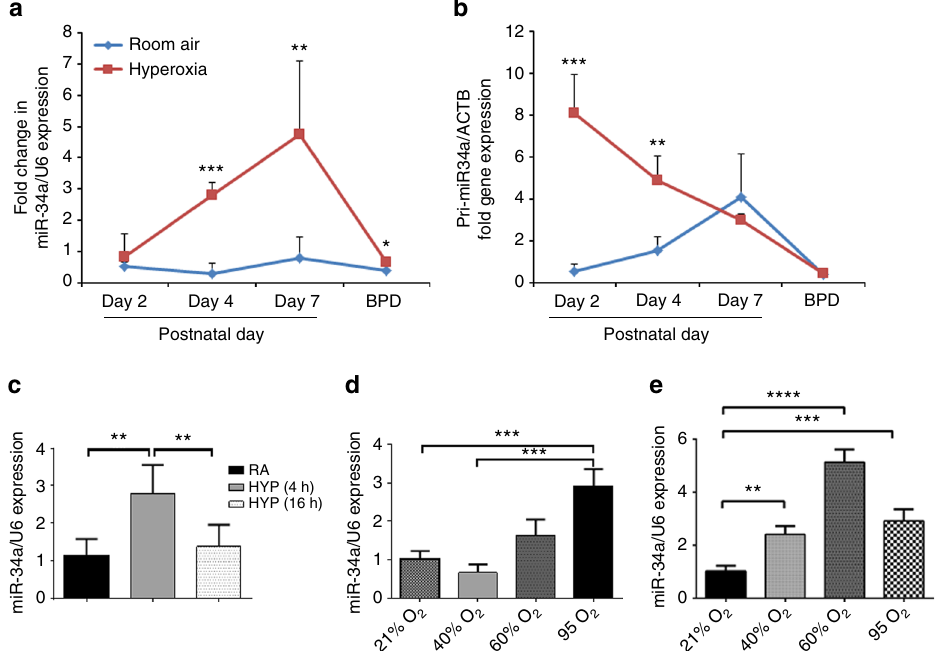
Fig. 1 Expression of miR-34a in hyperoxia exposed NB lungs and type 2 cells. a Representative graphs showing miR-34 expression in WT NB mice exposed to hyperoxia for 2, 4, and 7 days after birth and in the BPD model. b Primary miR-34a expression is shown in hyperoxia exposed and BPD murine lung tissue as compared to controls. c Freshly isolated type 2 epithelial cells were used for measuring miR-34a expression in room air (RA) and after 4 h and 16 h HYP (95% O 2 ). d , e MLE12 cells were exposed to different concentrations of oxygen (21, 40, 60, and 95%) for 24 h and 48 h, respectively.